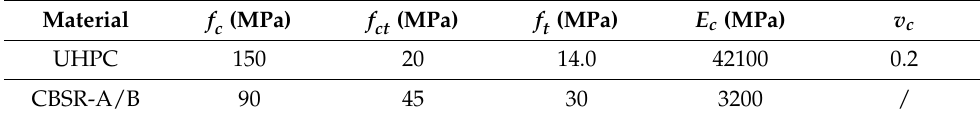
Figure 3. Material performance test of the UHPC. Table 3. Mechanical properties of UHPC and epoxy Table 2. Mix the proportion of UHPC.